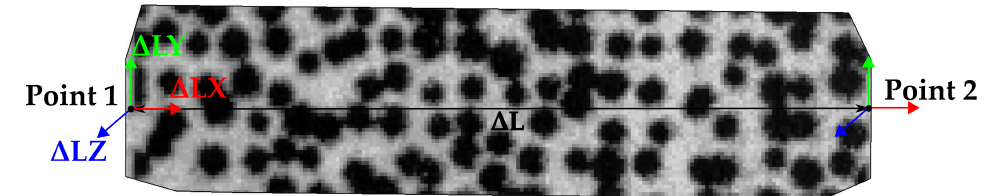
Figure 7. Length variation ( ∆ L ) between two points, and variation per axis direction ∆ LX , ∆ LY , and ∆ LZ .